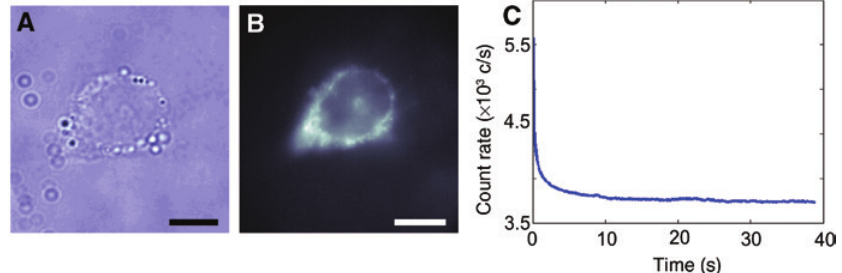
Figure 5: (A) Representative bright-field microscope image of an untreated HaCaT cell. (B) Wide-field confocal fluorescence of the same untreated HaCaT cell. The scale bars are 10 μ m in length. (C) Corresponding count trace for the untreated HaCaT cell, from wide-field confo- cal modality, showing typical bleaching of the cell’s